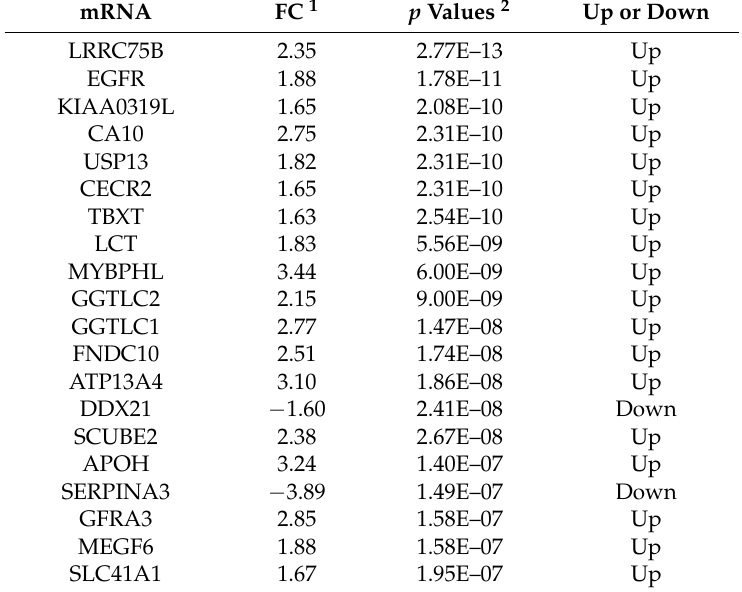
Table 4. Top 20 mRNAs that were differentially expressed between EGFR -mutated compared to EGFR wild-type lung adenocarcinoma.